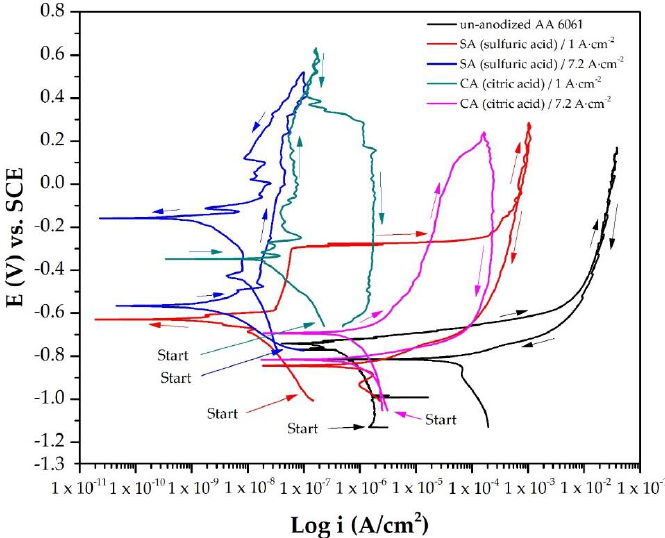
Figure 1. Cyclic potentiodynamic polarization of the un-anodized AA 6061 and samples anodized in 3.5 wt.% NaCl solution. 3.5 wt.% NaCl Table 3. Electrochemical parameters using cyclic potentiodynamic polarization of AA 6061 and anodized samples in 3.5 wt.% NaCl solution.